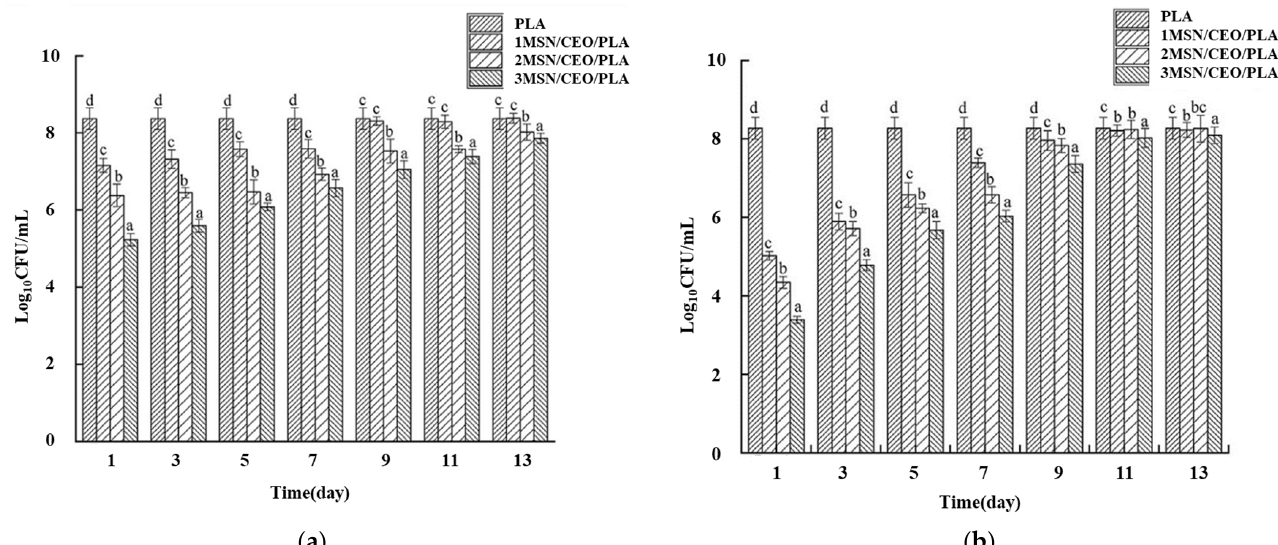
Figure 5. Antibacterial properties of 1MSN/CEO/PLA, 2MSN/CEO/PLA, 3MSN/CEO/PLA, and PLA films: ( a ) E. coli , ( b ) S. aureus . Reprinted with permission from Ref. [85], published by Elsevier, 2022. a–d values indicate values which were significantly different ( p < 0.05), where a was the lowest